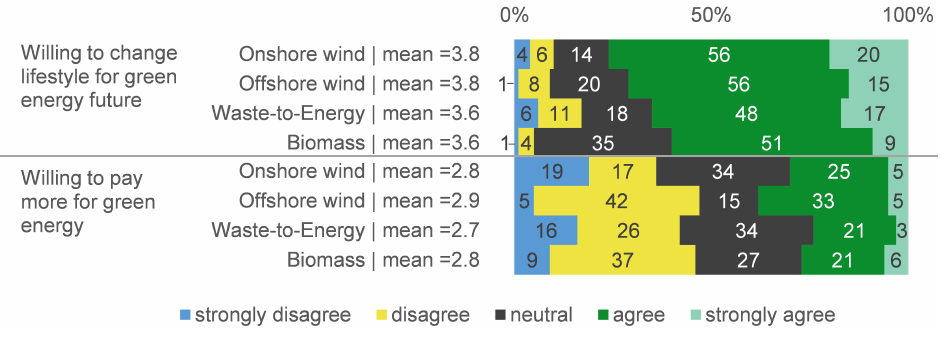
Figure 1. Distribution of participants willing to change and to pay in % per survey group. For the calculation of the mean value, a scale from 1: very negative to 5: very positive was used.